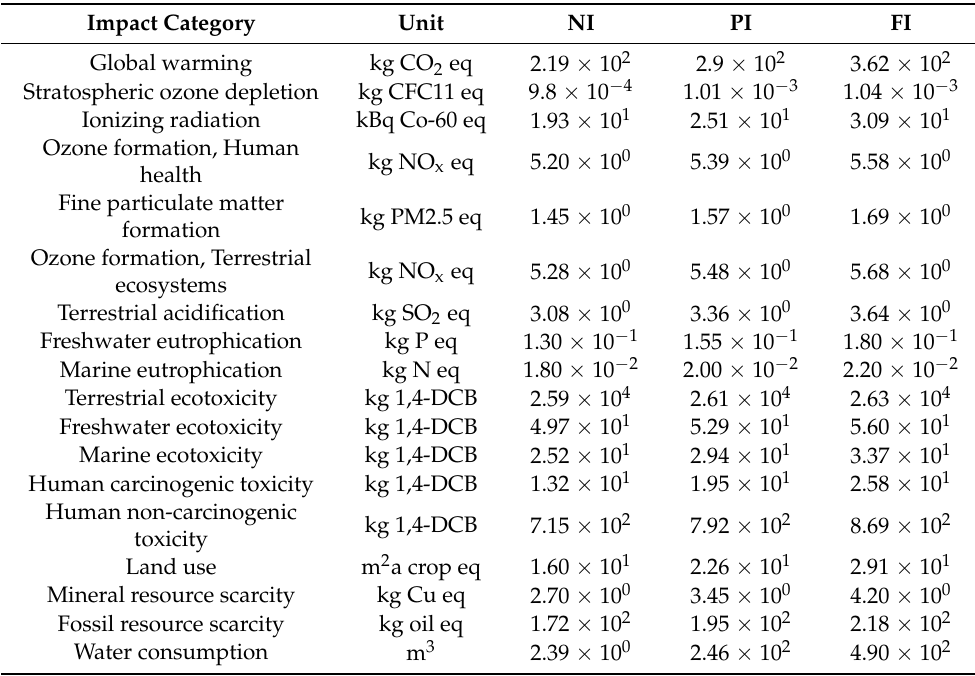
Table 7. Life Cycle Impact Assessment through the ReCiPe Midpoint method (per hectare).